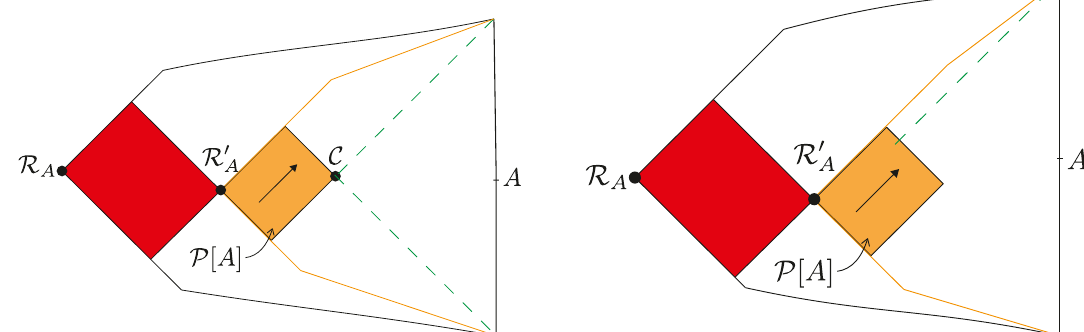
Figure 1 . Left: given a boundary region A , the RT surface R A and the corresponding entanglement wedge W [ A ] (with black boundary), the outermost extremal surface R 0 and the corresponding E A outermost wedge W [ A ] (with orange boundary) is shown. The green dotted lines mark the causal O horizons and therefore the boundaries of W [ A ] . The intersection of the horizons defines the causal C surface C . Right: we consider bulk perturbations that don’t change the state in W [ A ] , but change C the geometry so as to bring parts of W [ A ] ∩ W [ A ] into the causal past of D ( A ) as shown. A E C signal (marked by the black straight arrow) can then reach D ( A ) . The causal past of D ( A ) cannot be extended beyond R 0 under this class of operations. The peninsula P [ A ] , marked in orange, is A therefore the largest region that can be placed in the causal past (or future) of D ( A ) using such operations, while the red region can never be accessed this